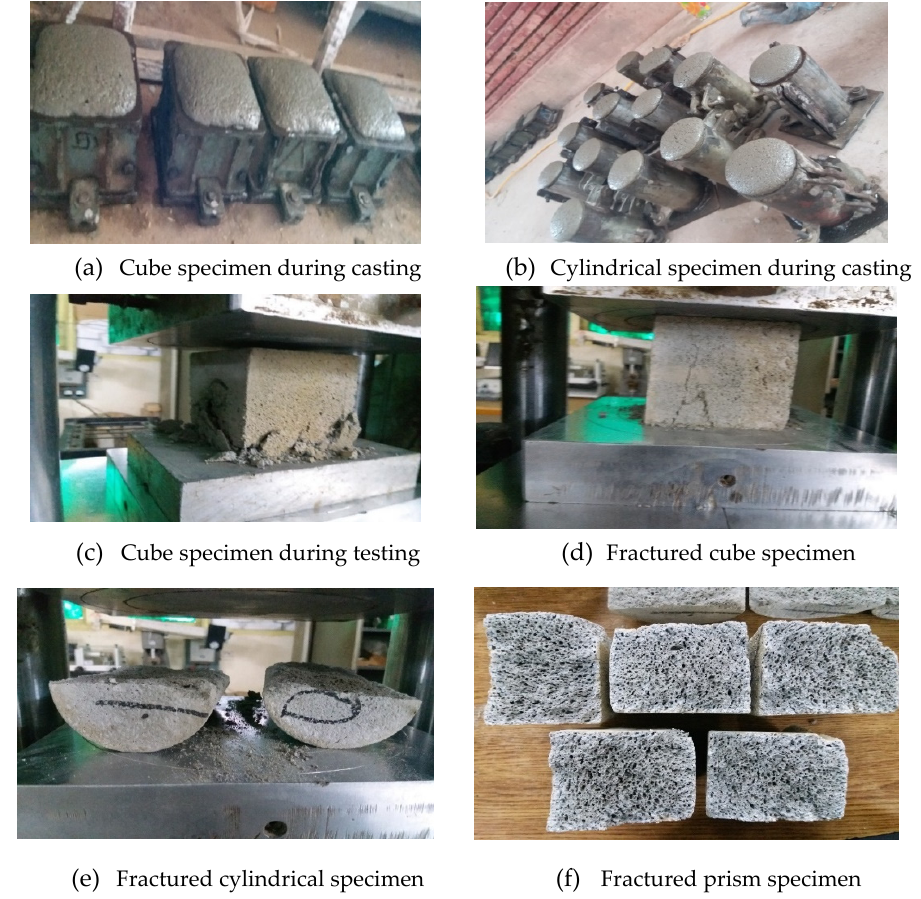
Figure 5. Fabricated and fracture images of all specimens ( a – f ).